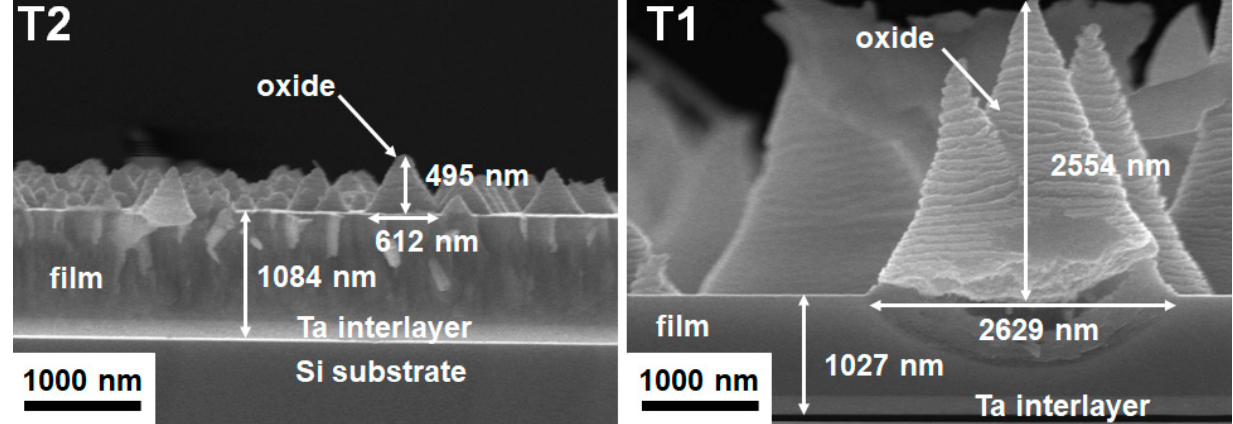
Figure 13. XSEM images of the T2 and T1 samples annealed at 600 °C in 1% O 2 –Ar for 8 h.